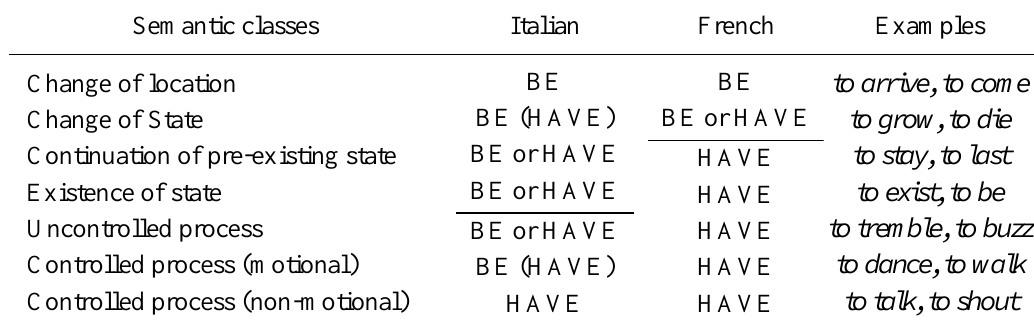
Table 3 . The UH in Italian and French (adapted from Sorace & Legendre, 2003) Semantic